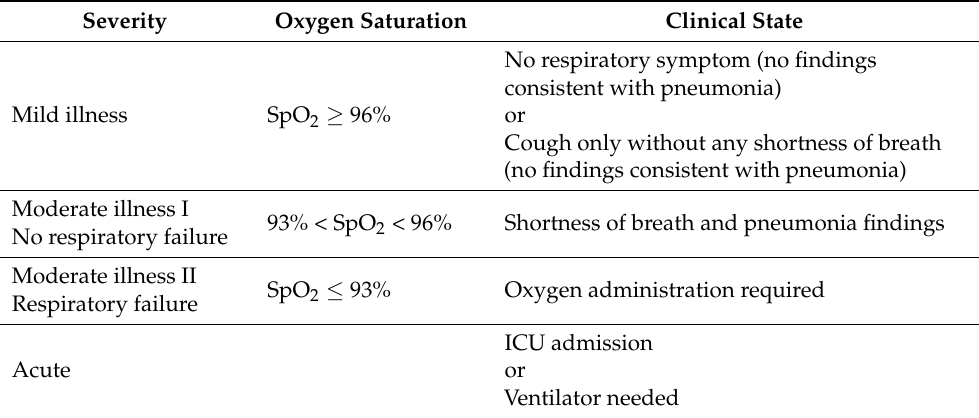
Table 1. Classification of the severity of symptoms associated with COVID-19 infection. Severity Oxygen Saturation Mild illness